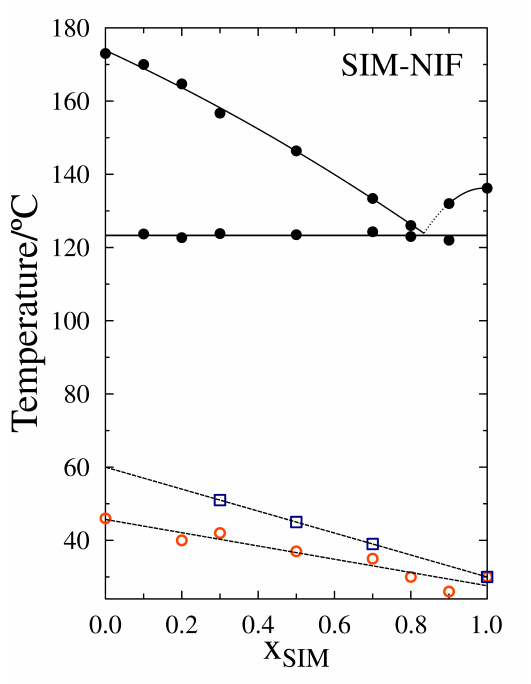
Figure 3. Phase transition diagram for the binary system SIM-NIF. Liquidus and eutectic temperatures shown in filled circles. In the phase diagram are also included the glass transition temperatures measured immediately after the quenching (empty circles) and after storage (empty